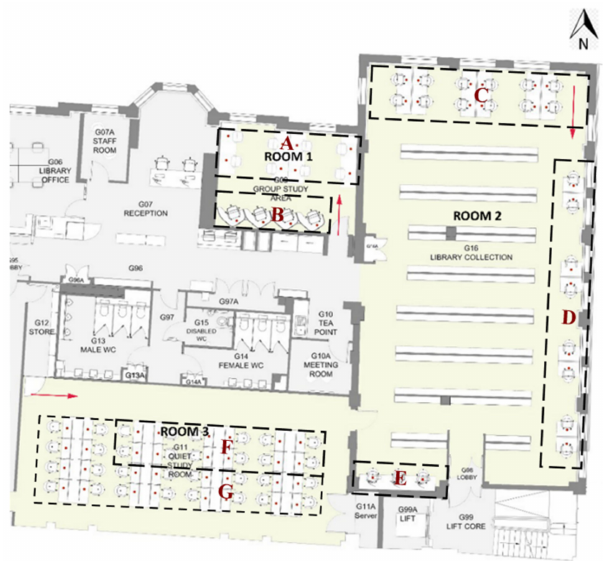
Figure 2. The zones with the common features in the library.